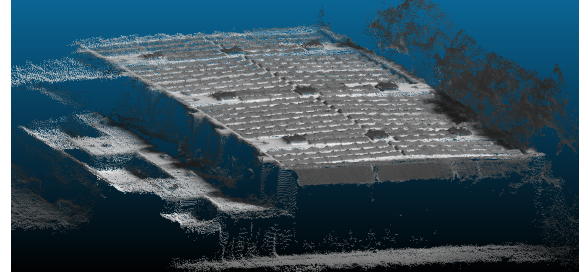
Figure 9. Ortho image mosaic generated from the image se- quence and the point